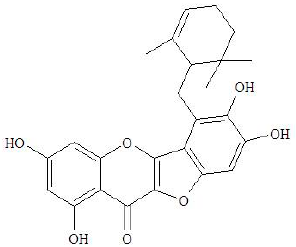
Figure 1. Structure of Ugonin M.